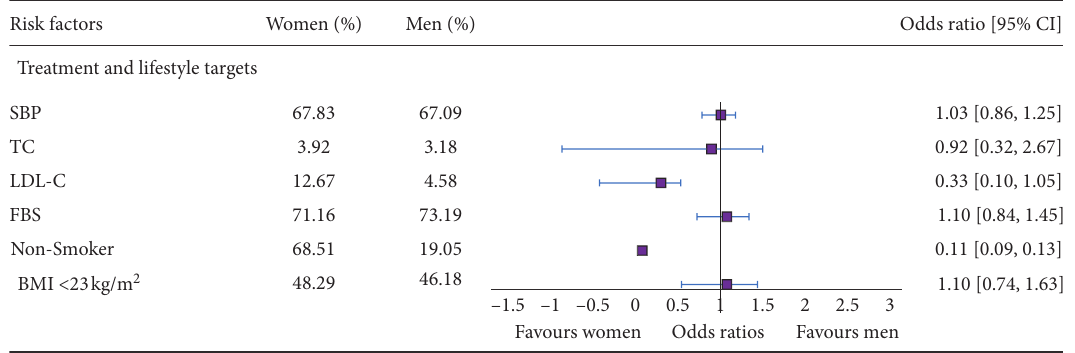
Figure 1: Age-adjusted sex differences in the risk factor management.